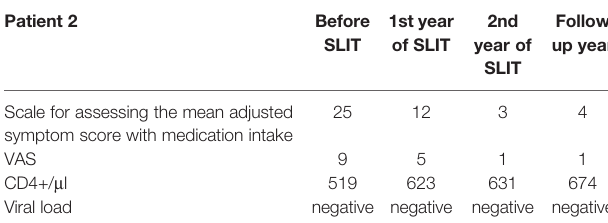
TABLE 2 | Development of CD4+ Cell Count, HIV RNA, questionary